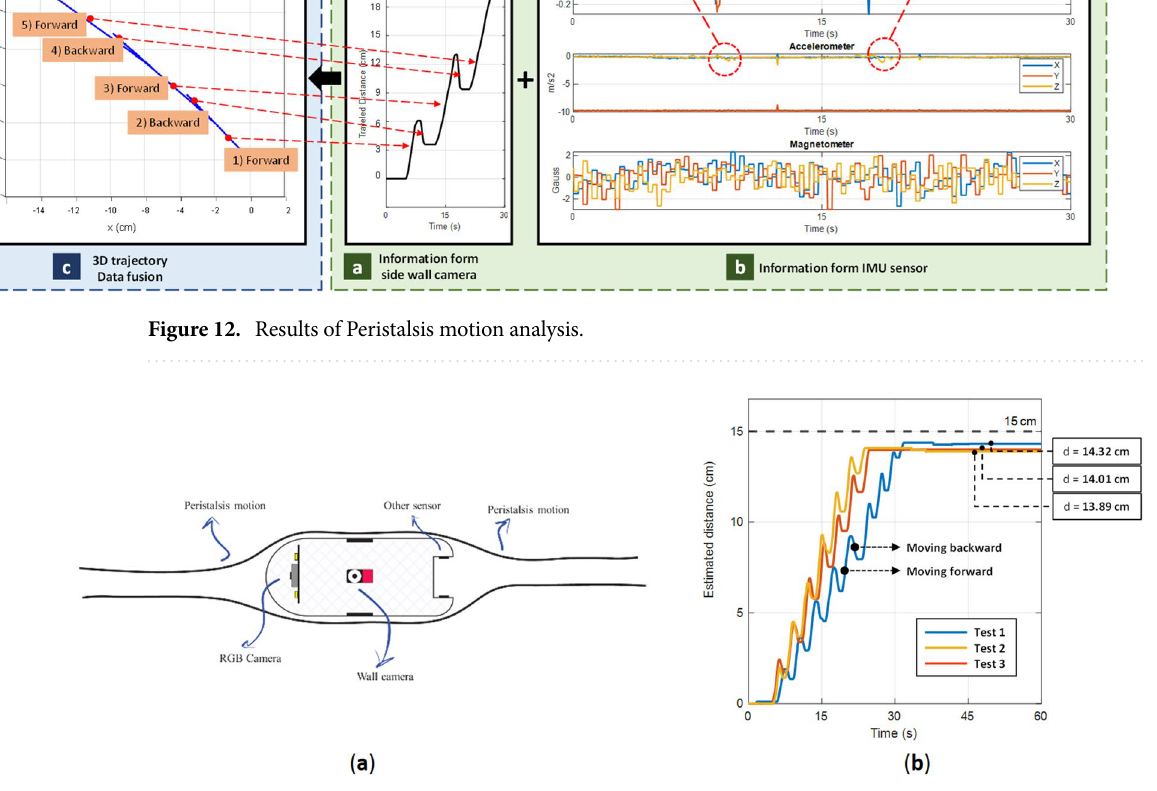
Figure 13. ( a ) Peristalsis motion ( b ) experiment